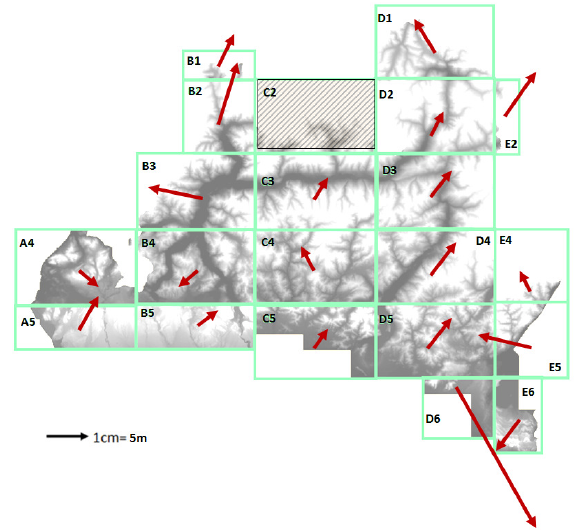
Figure 7. Estimates of the translations between the LR Lombardy and the HR LiDAR DTMs. Individual translations have been estimated for the subgrids of the regional DTM. Grid C2 has no overlap with the Lidar